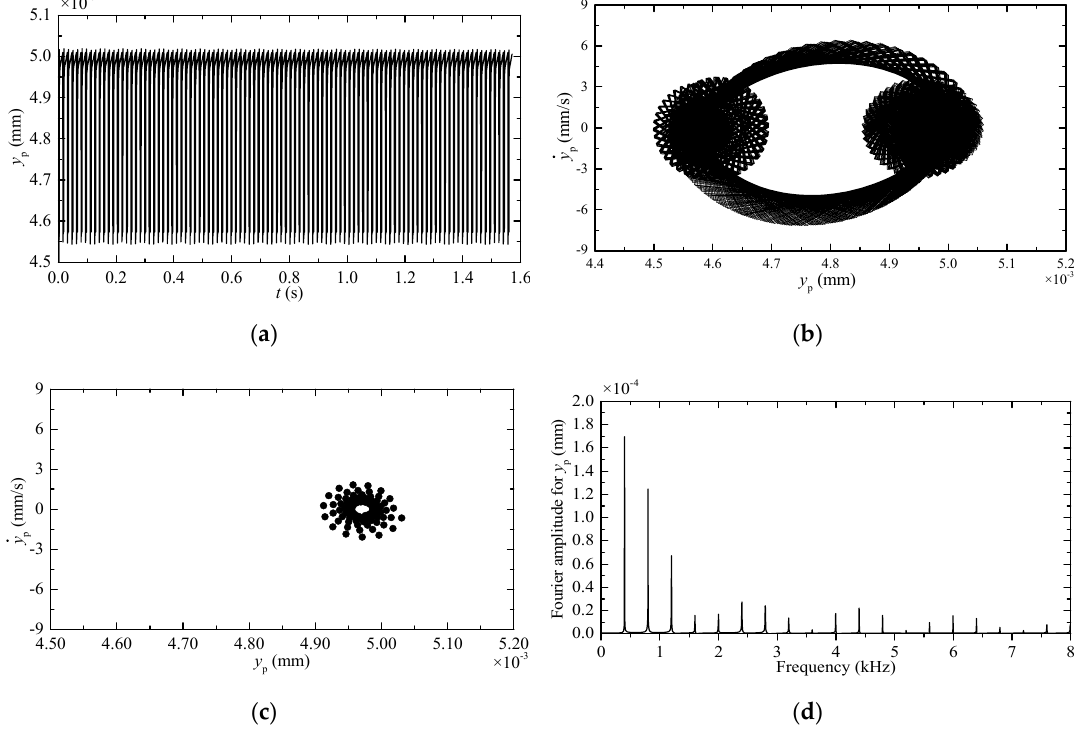
Coatings 2019 , 9 , x FOR PEER REVIEW E E = ) along LOA is analyzed by comparing the (a) Figure 9. The vibration response of pinion ( c s Figure 9. The vibration response of pinion ( E c = E s ) along LOA is analyzed by comparing the ( a ) time time history curve, (b) phase curve, (c) Poincare map, and (d) FFT spectrum. history curve, ( b ) phase curve, ( c ) Poincare map, and ( d ) FFT spectrum.